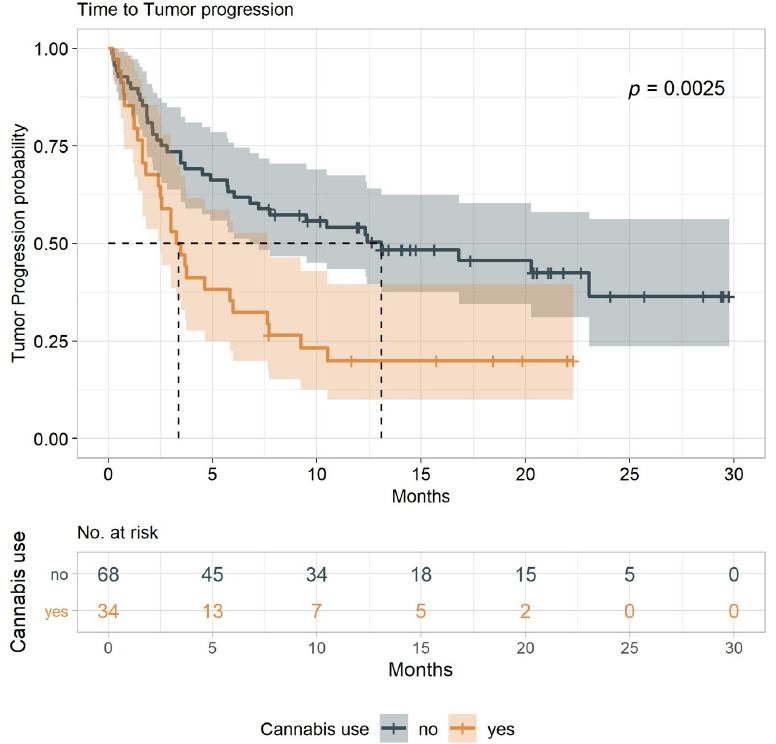
Figure 1. Durability of time to tumor progression (TTP) among patients with advanced cancers receiving immunotherapy, comparing cannabis users to nonusers. Median TTP was 3.4 months (95% confidence interval (CI), 1.8–6.0) for cannabis users and 13.1 months (95% CI, 6.0–NA) for